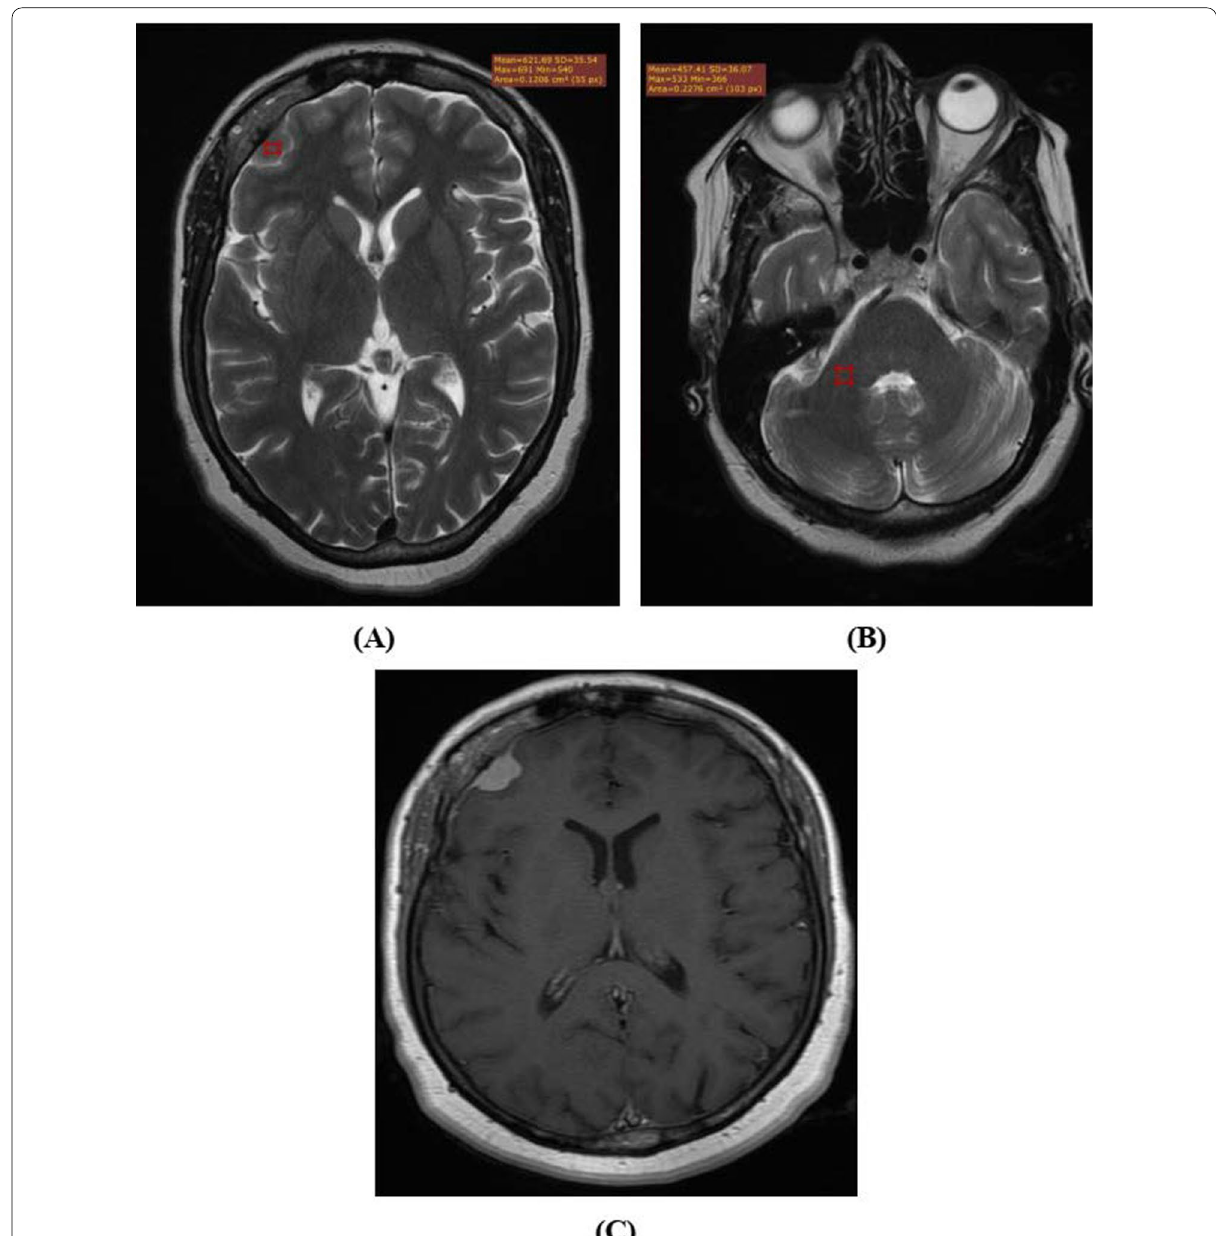
Fig. 4 MRI of firm consistency right frontal convexity meningioma. A , B Axial T2-weighted MR images at the level of right frontal convexity meningioma and at the level of middle cerebellar peduncles showing TCTI ratio of 1.2, proved surgically to have firm consistency. C Axial T1 post contrast showing intense